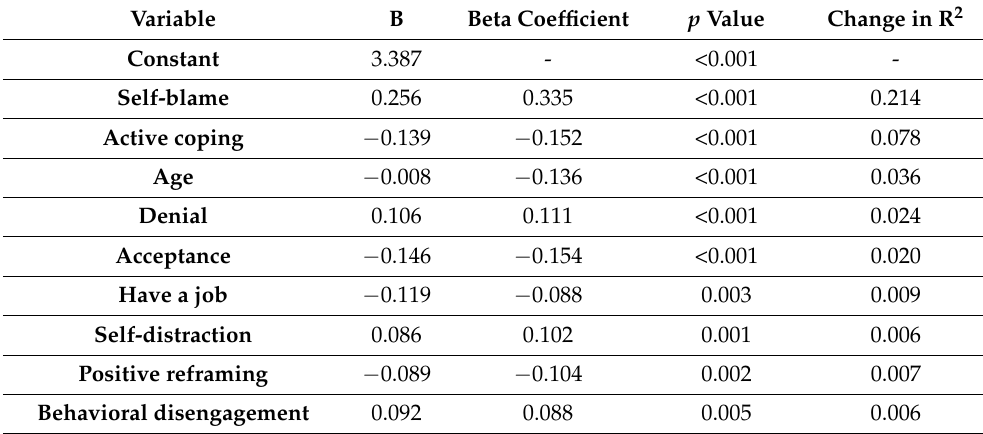
Table 5. Multiple regression analysis for stress in